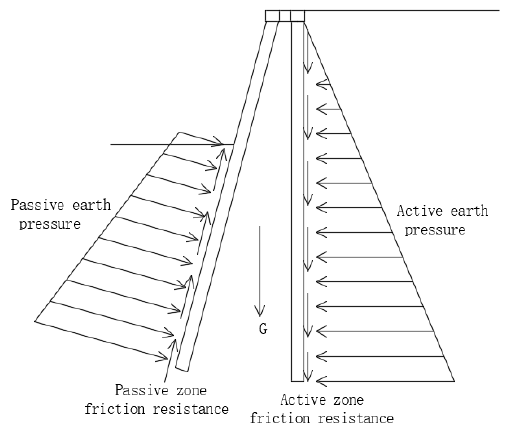
Figure 11. The behavior of force analysis of inclined-straight pile. Where, (G is the gravity of soil between combined piles).